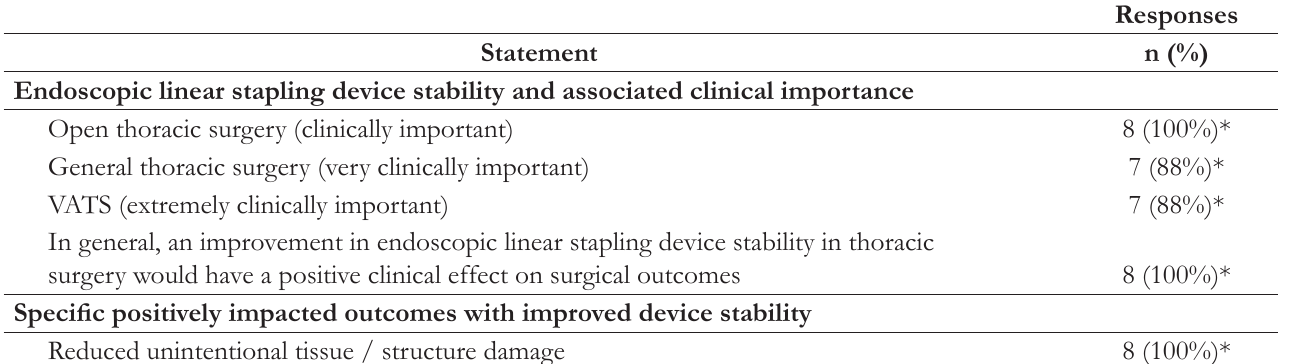
Table 6. Survey 2: Results on the Clinical Importance of Device Stability and Improved Device Stability